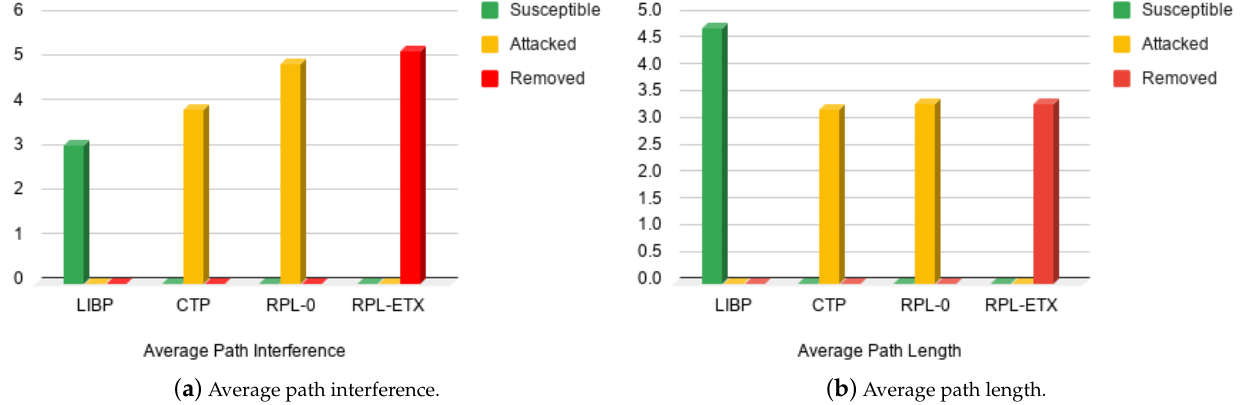
Figure 10. Routing profile: Interference and path